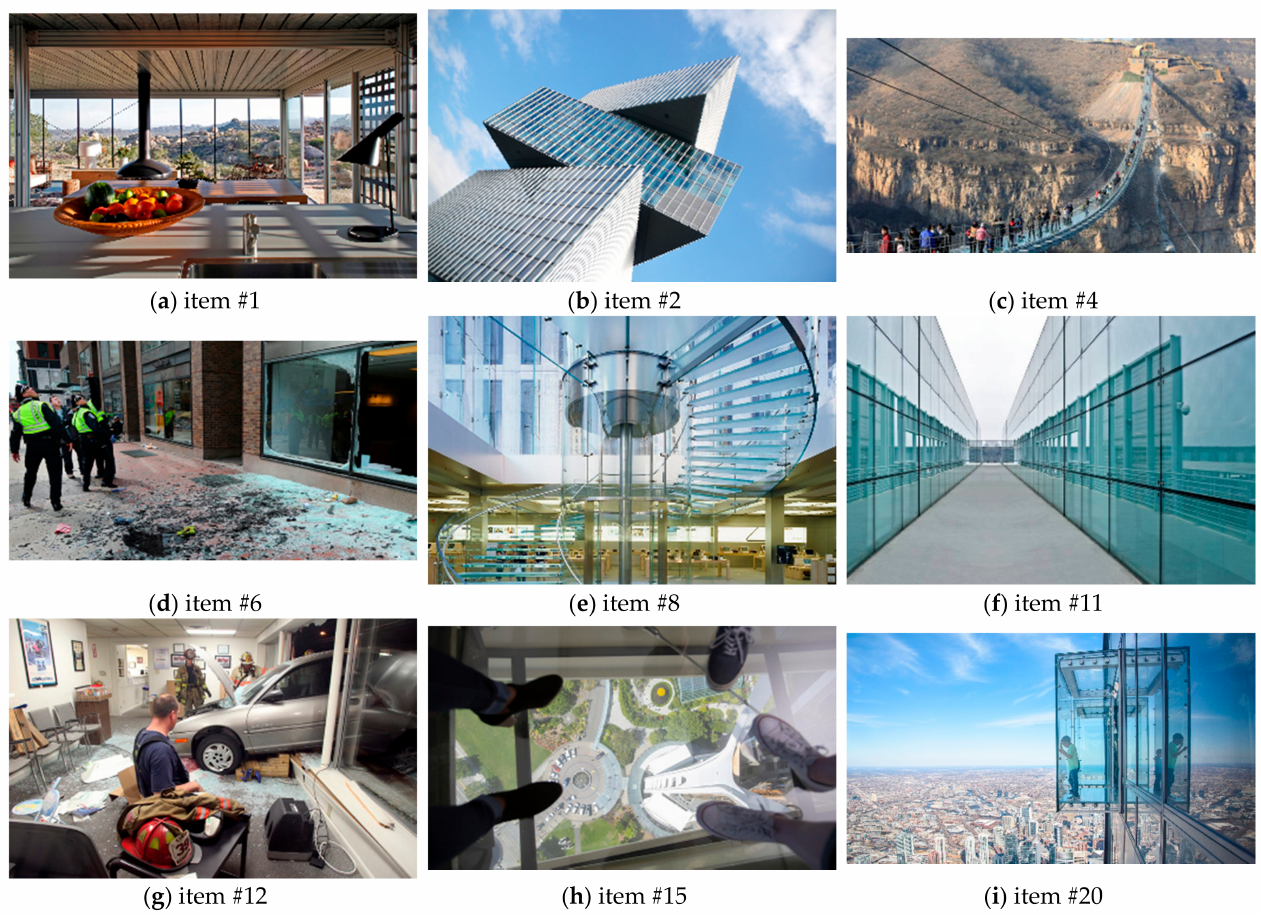
Figure 6. Selection of static input sources for the first stage of the static virtual experiment (examples from the set of 27 items): ( a ) private room (Off-grid itHouse, Pioneertown, USA; adapted from [38], © Airbnb); ( b ) Amsterdam RAI Hotel, NL (adapted from [39], © Egbert de Boer); ( c ) Hongyagu bridge, Hebei, CN (adapted from [40], © REUTERS/Stringer); ( d ) windows under a blast hazard (adapted from [29], © C. Bedon); ( e ) stairs of the Apple Cube, New York, USA (adapted from [41], © Sedak GmbH and Co KG); ( f ) facade and walls (adapted from [29], © C. Bedon); ( g ) window under vehicle impact (adapted from [42], © Times Colonist); ( h ) Space Needle tower (Seattle, WA, USA; adapted from [43], © Space Needle LLC and John Lok); ( i ) skydeck (Willis Tower, Chicago, USA; adapted from [44], © Ranvestel